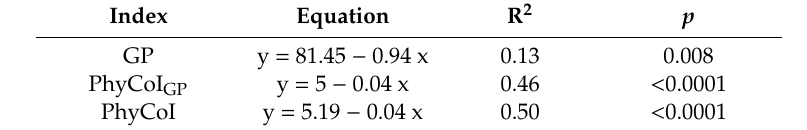
Table 3. Linear Regression and ANOVA results of correlations with eutrophication (TSI SD ).